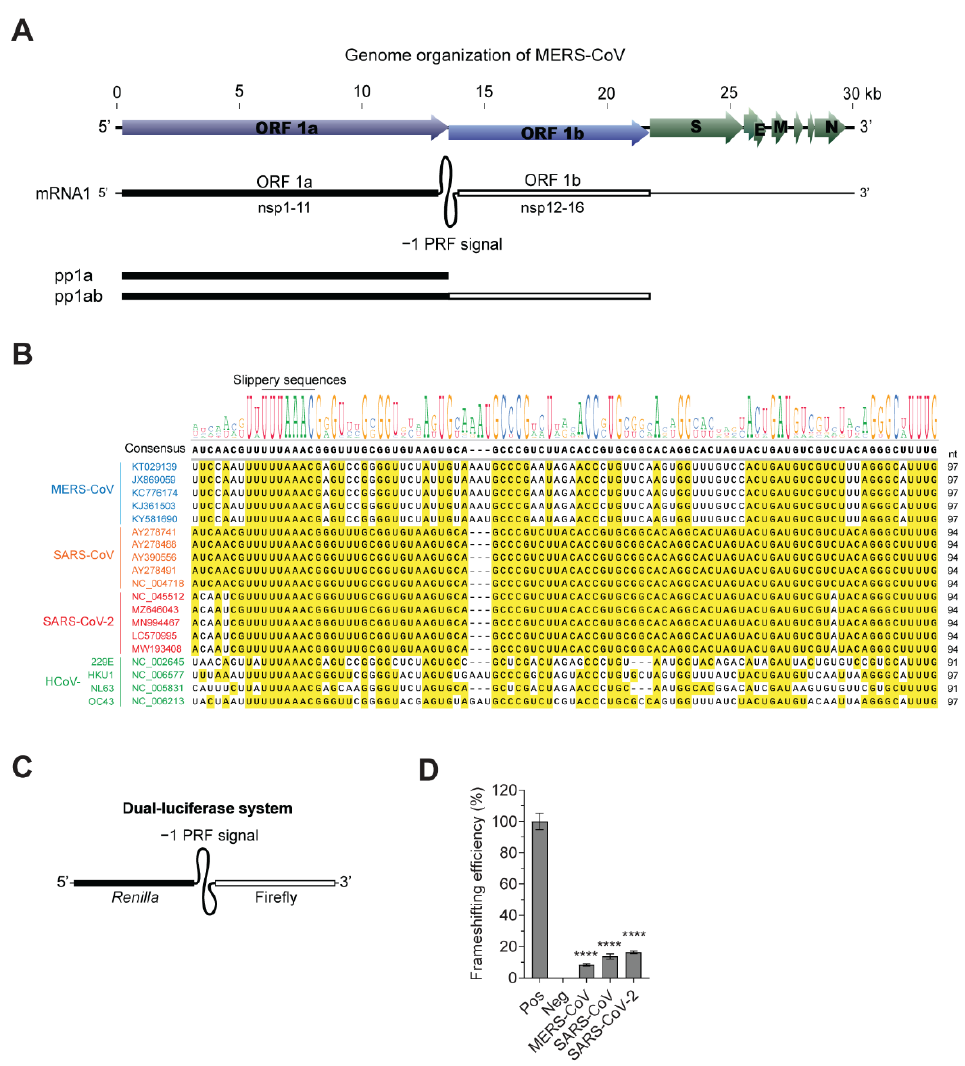
Figure 1. Frameshifting ratio of MERS-CoV, SARS-CoV-1, and SARS-CoV-2. ( A ) Schematic diagram of the genomic organization of MERS-CoV. ( B ) Alignment of the full sequences of − 1 PRF signals of MERS-CoV, SARS-CoV, SARS-CoV-2, HCoV-229E, HCoV-HKU1, HCoV-NL63, and HCoV-OC43. Slippery sequences (UUUAAAC) are indicated above the aligned sequences. ( C ) Schematic diagram of a reporter system. ( D ) Frameshifting efficiencies of MERS-CoV, SARS-CoV, and SARS-CoV-2. Positive control expressing Renilla and firefly luciferases fused without − 1 PRF signal, was set to 100% and negative control only expressing Renilla luciferase to 0%. Pos, positive control; Neg, negative control. **** p < 0.0001 vs. positive control (one-way analysis of variance (ANOVA) with Dunnett’s multiple comparisons test).